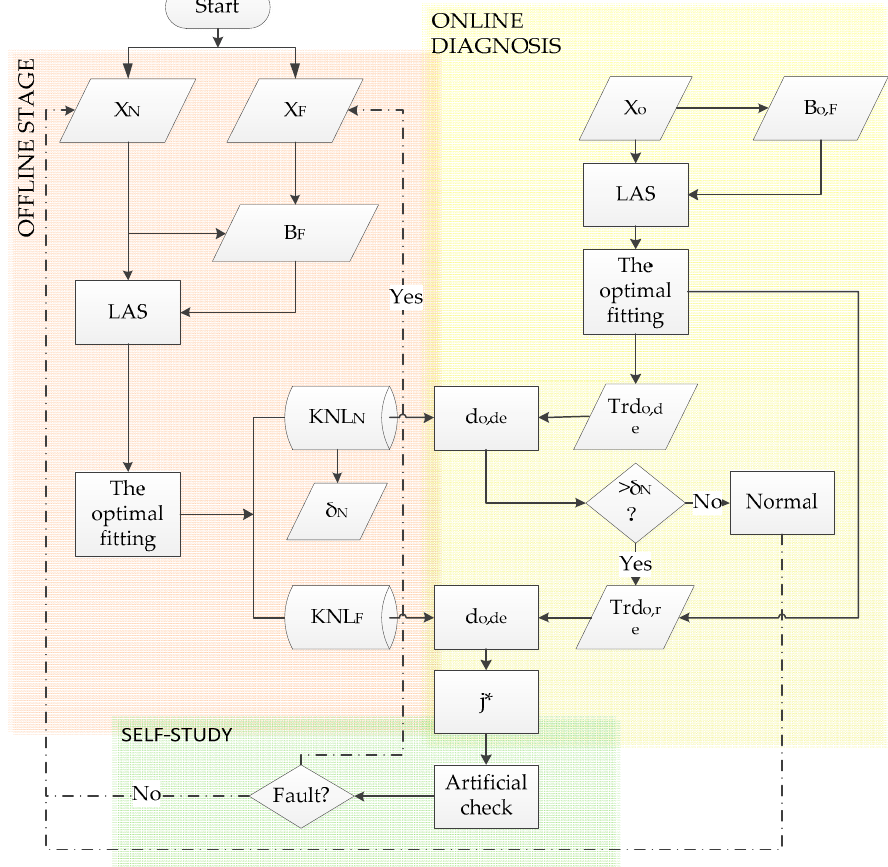
Figure 3. The fault diagnosis framework based on QTA and LAS.